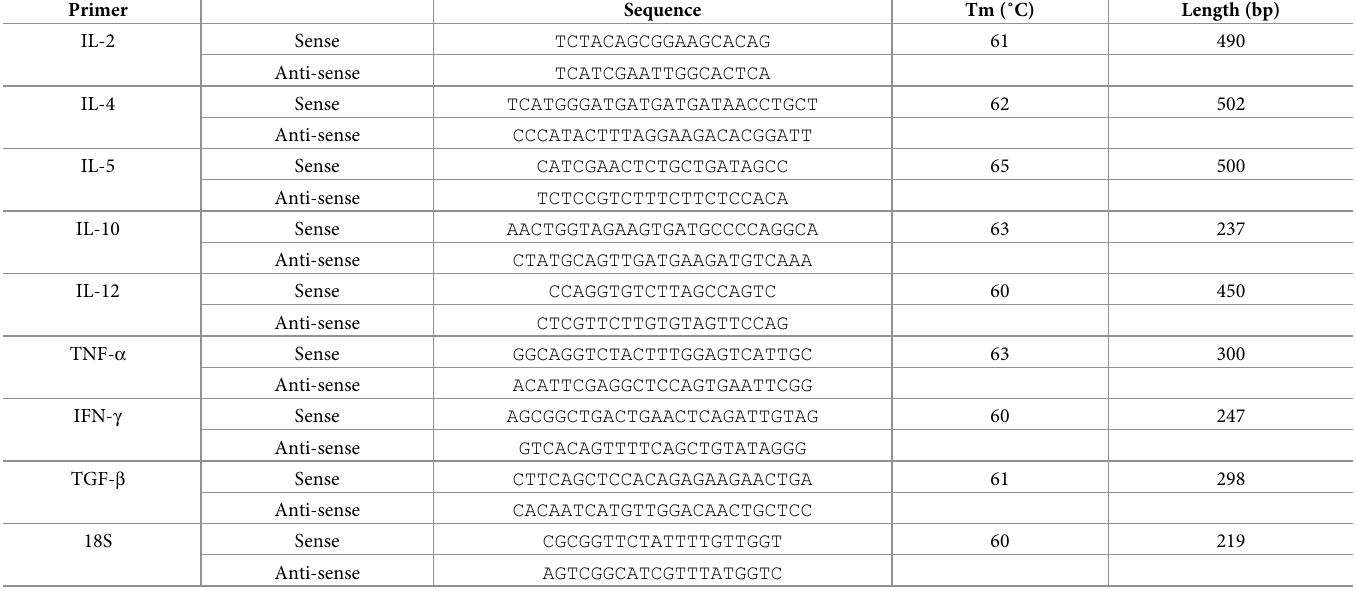
Table 1. Primer sequence. The primers were designed based on reported sequences from the Gene Databank (NCBI, NIH).